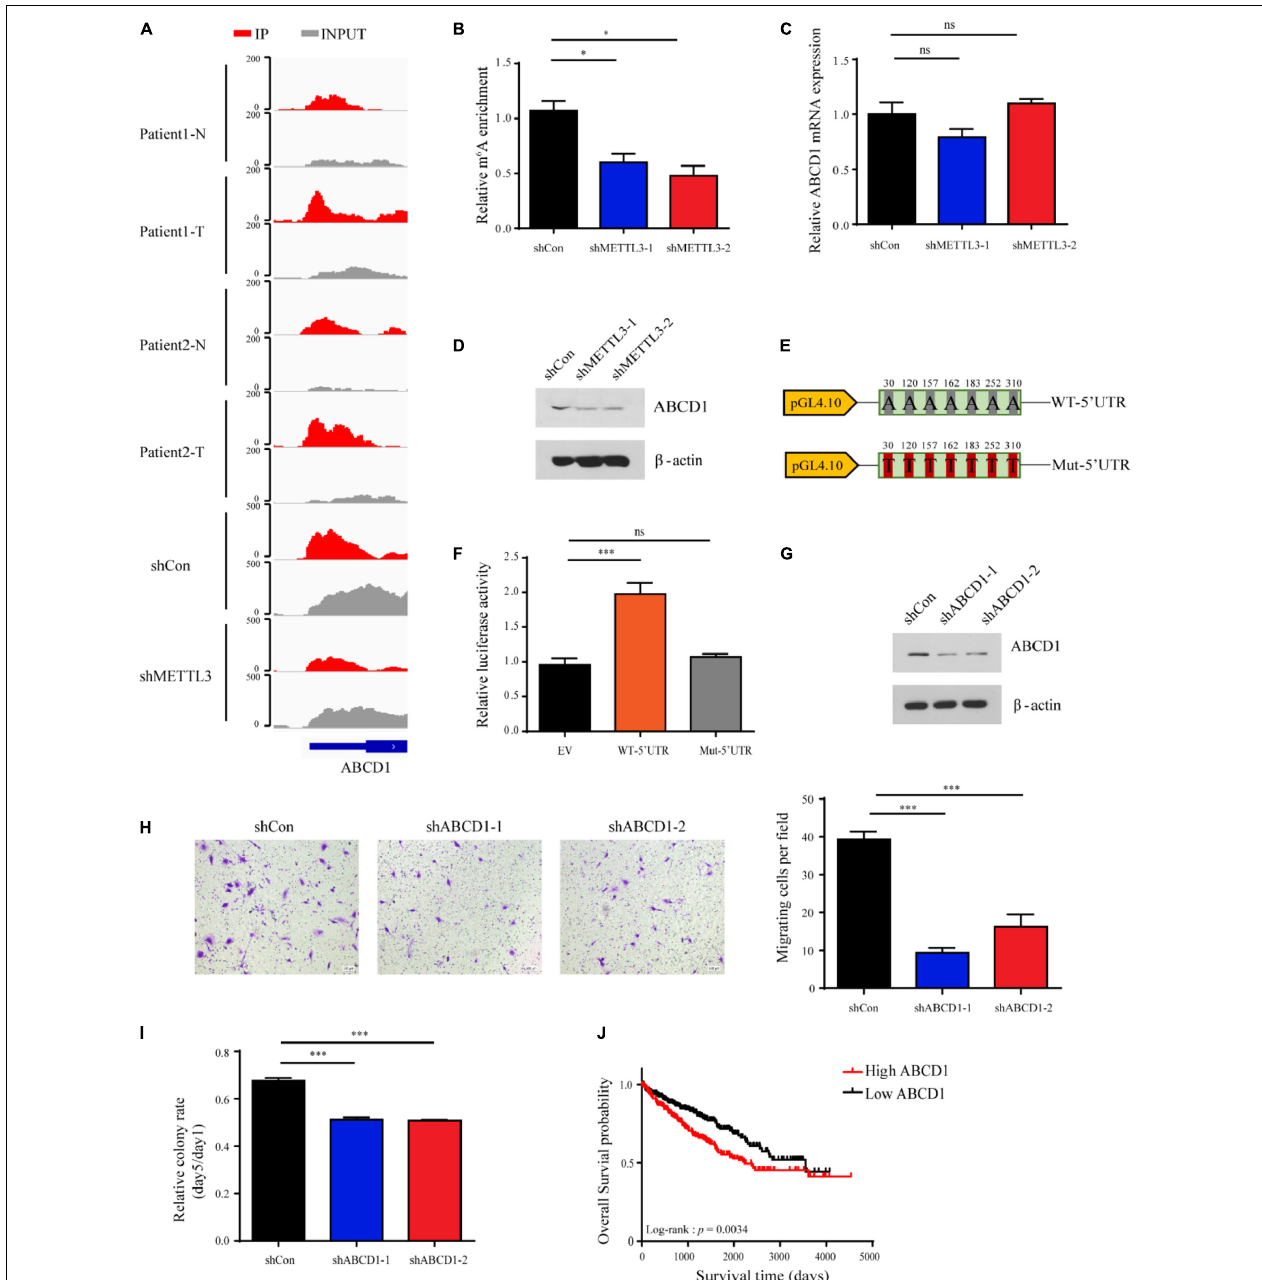
FIGURE 6 | ABCD1 is a key downstream target of METTL3 in ccRCC. (A) The read distribution in the 5 (cid:48) UTR of ABCD1 mRNA of the normal and tumor tissues, and the shCon and shMETTL3 A498 cells. The values on the left side of the track represent the range of normalized IP and input levels. (B) m 6 A enrichment in the 5 (cid:48) UTR of ABCD1 mRNA in the METTL3 knockdown A498 cells verified by MeRIP-qPCR. Error bars represent the SD of the mean. (C) ABCD1 mRNA expression levels in the shCon and shMETTL3 A498 cells verified by RT-qPCR. Error bars represent the SD of the mean. (D) ABCD1 protein levels upon knockdown of METTL3 in A498 cells determined by western blotting. β -actin was used as a loading control. (E) pGL4.10 luciferase reporter constructs containing fragments of the human ABCD1 5 (cid:48) UTR with wild-type m 6 A sites (WT-5 (cid:48) UTR) or mutant (A-to-T mutation) m 6 A sites (Mut-5 (cid:48) UTR) are shown. The position of the m 6 A sites is numbered relative to the first nucleotide of the 5 (cid:48) UTR. (F) Relative luciferase activity in control constructs (EV) or constructs containing the wild-type 5 (cid:48) UTR of ABCD1 (WT-5 (cid:48) UTR) or mutant m 6 A sites of ABCD1 (Mut-5 (cid:48) UTR). Firefly luciferase activity for each construct was first normalized to the co-transfected Renilla luciferase construct and then normalized to the control constructs (EV). (G) Western blot of ABCD1 in the A498 cells transduced with lentiviruses expressing scrambled short hairpin RNA (shCon) and two independent shRNAs targeting ABCD1 (shABCD-1 and shABCD1-2). β -actin was used as a loading control. (H) (left) and quantitatively analyzed (right) (scale bar, 500 µ m). Error bars represent (SD) three biological replicates. (I) Sphere-formation analysis of A498 cells transduced with ABCD1-targeting virus, normalized to the number of spheroid cells on day 1. Error bars represent the SD of the mean ( n = 3). (J) Kaplan-Meier survival curves of ccRCC patients based on ABCD1 mRNA expression in TCGA database. Patients were assigned to two subgroups according to the median ABCD1 mRNA expression (log-rank test). * P < 0.05, *** P < 0.001.